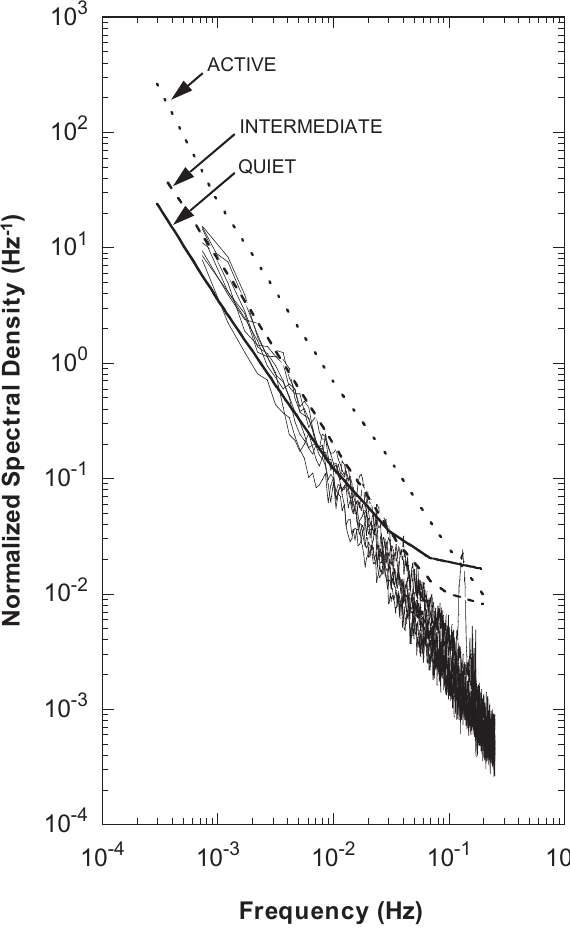
Fig. 11. Comparison of the normalized transverse IMF power spec- tra for the eight 3 He-rich events of Tables 1 and 2 and the nor- malized Siscoe et al. (1968) classification of the IMF activity level (from Table